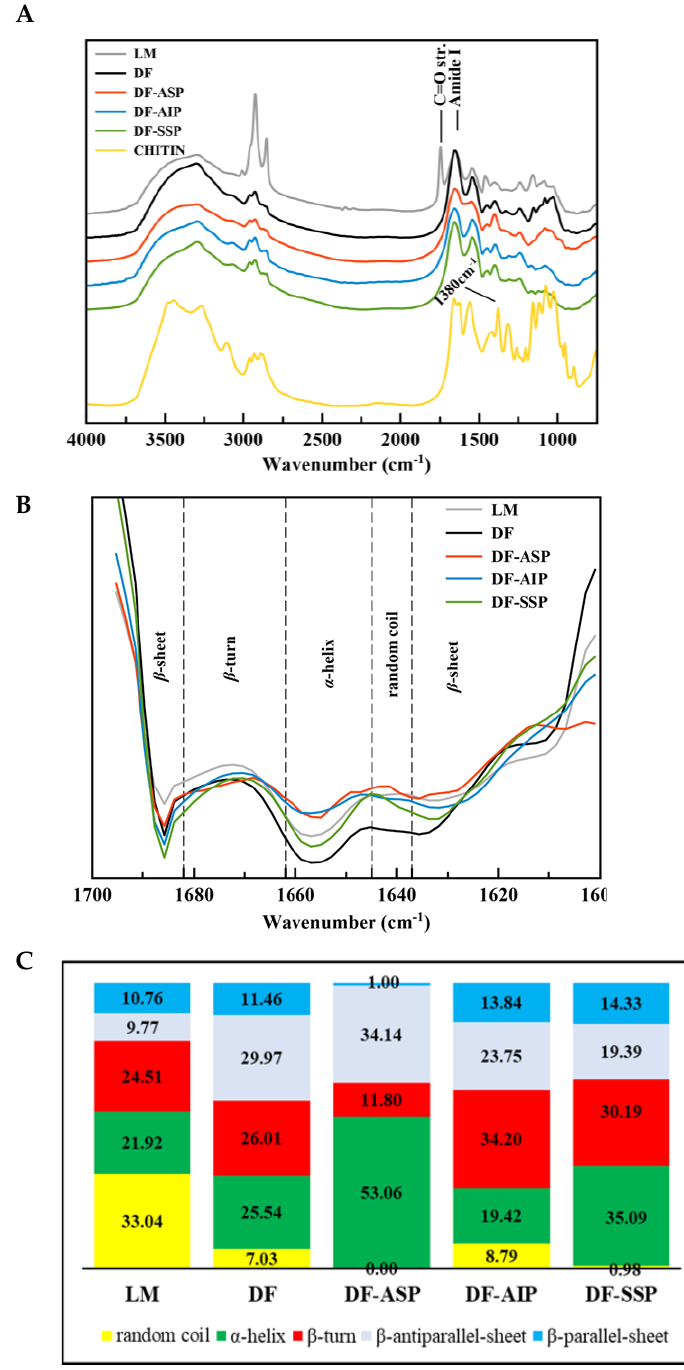
Figure 3. ( A ) Normalized FTIR spectra; ( B ) second derivative of the Amide I region; ( C ) contribution (%) of the different conformations to the protein secondary structure of the protein preparations. Notations as in Table 1.